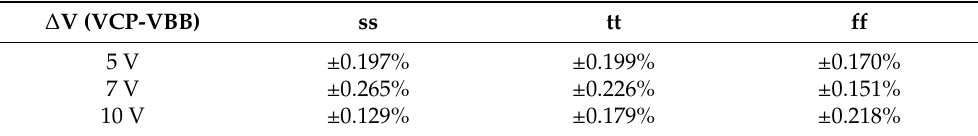
Figure 8. Output voltage VCP when A1A2 = 01, VBB = 24 V. Table 2. Deviation at different process